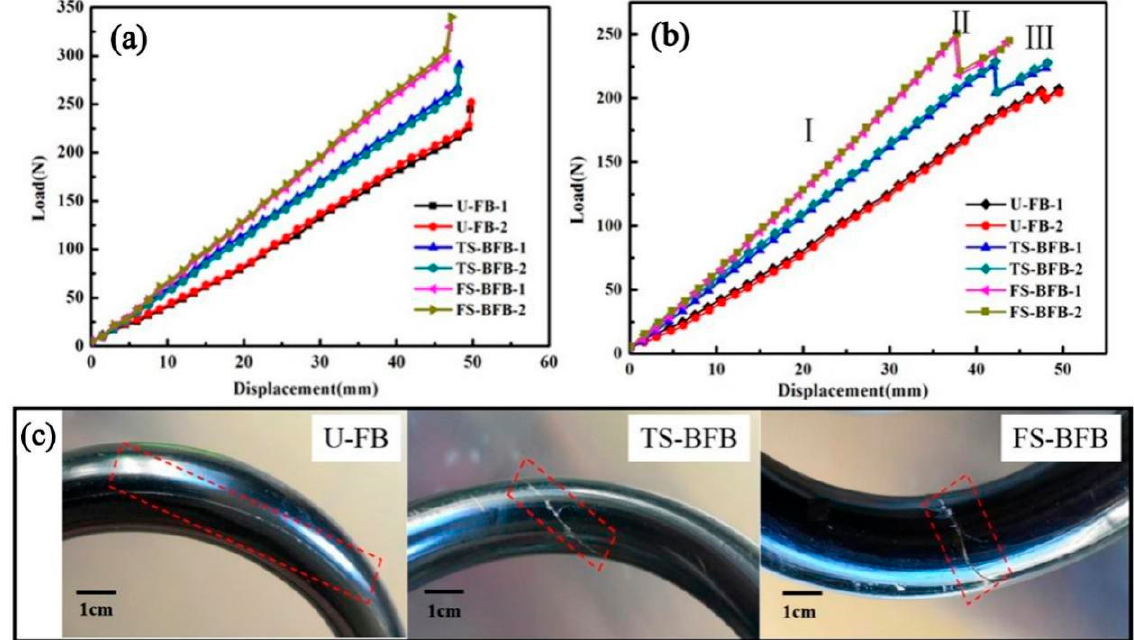
Figure 8. ( a ) Load-displacement curves before the HCS samples failure; ( b ) the failure curves of an HCS; and ( c ) the cracks in helical springs with different structures.